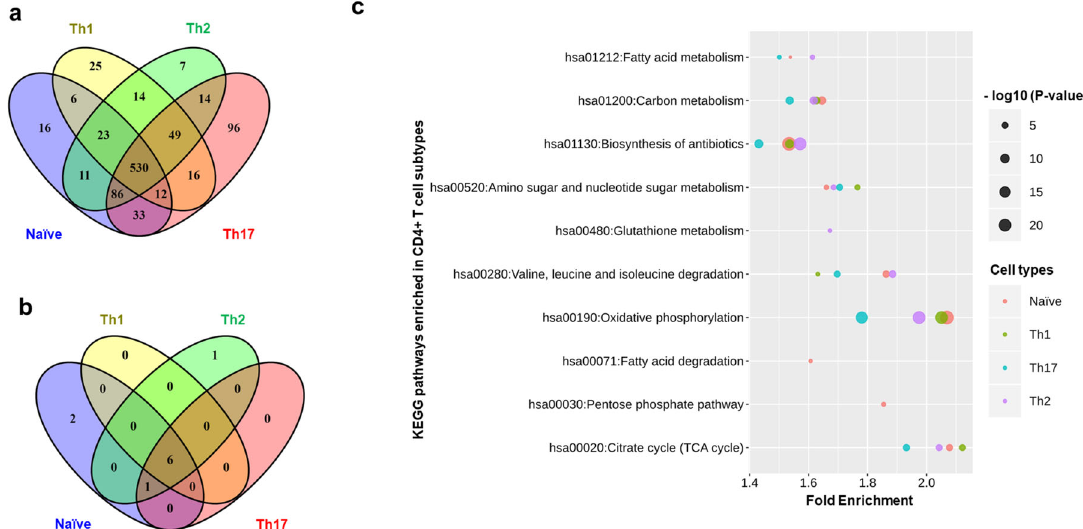
Fig. 2 Construction of metabolic models in CD4 + T cells. a Expressed metabolic genes identi fi ed using integrated transcriptomics and proteomics data of CD4 + T-cell subtypes. b KEGG pathway enrichment analysis of expressed genes in each cell type using all 1892 metabolic genes as a background. c Fold enrichment and P -values (larger sizes correspond to lower P -values) of KEGG pathways enriched across CD4 + T-cell subtypes. A pathway was considered signi fi cantly enriched with P -value < 0.05 and false discovery rate (FDR)